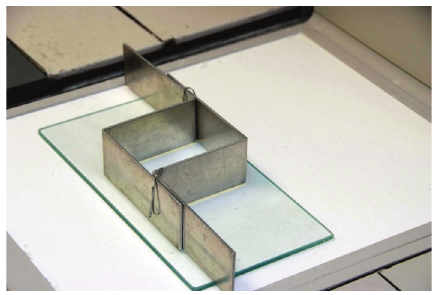
Figure 3: Adjustable embedding